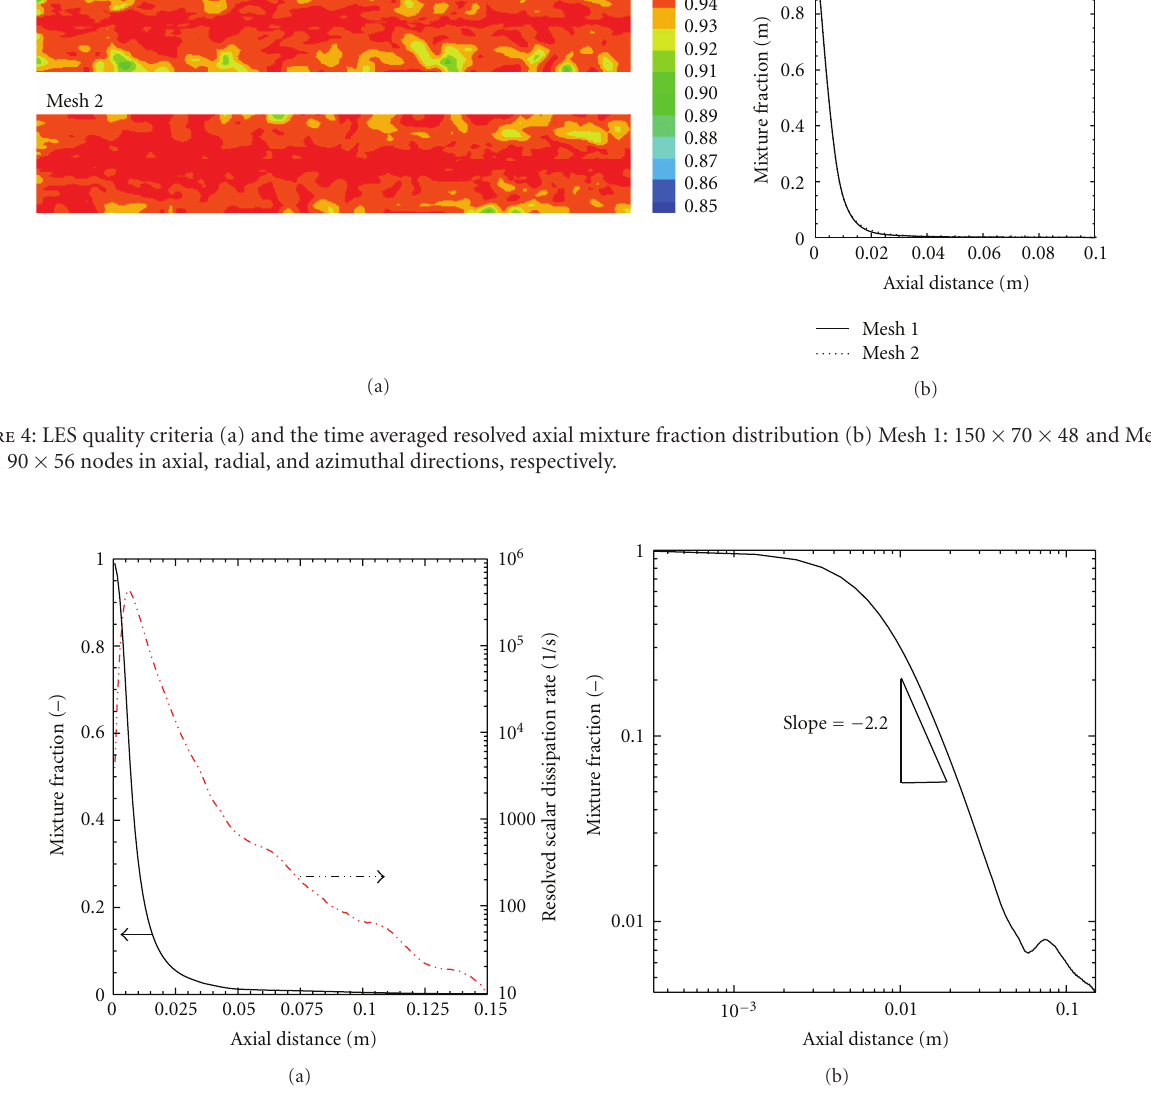
Figure 5: Time averaged resolved mixture fraction and scalar dissipation